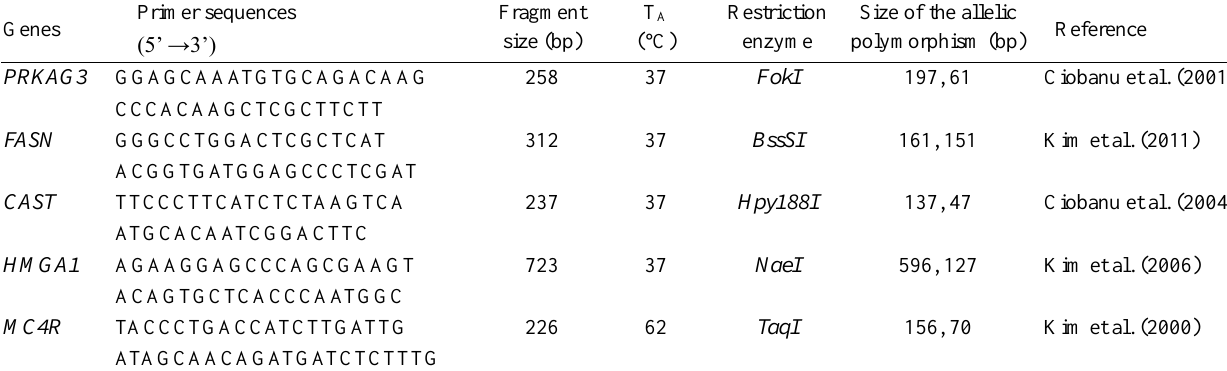
Table 1. PCR primers and restriction enzymes used for SNP genotyping of five candidate genes Primer Genes